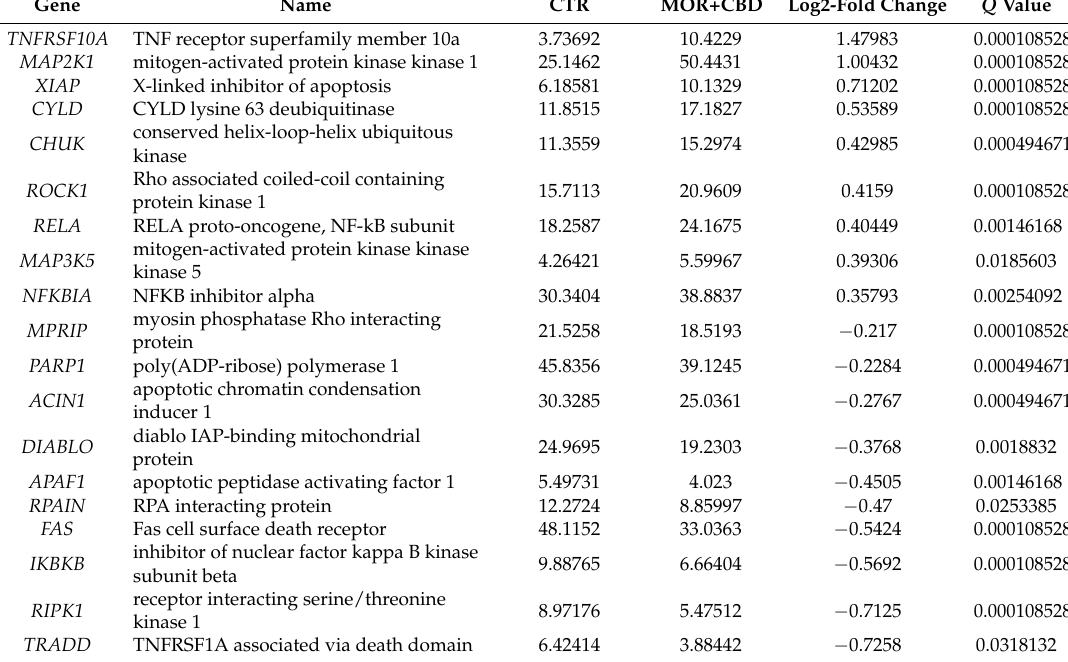
Table 4. Up- and downregulated genes, involved in the “Cell death receptor signaling”